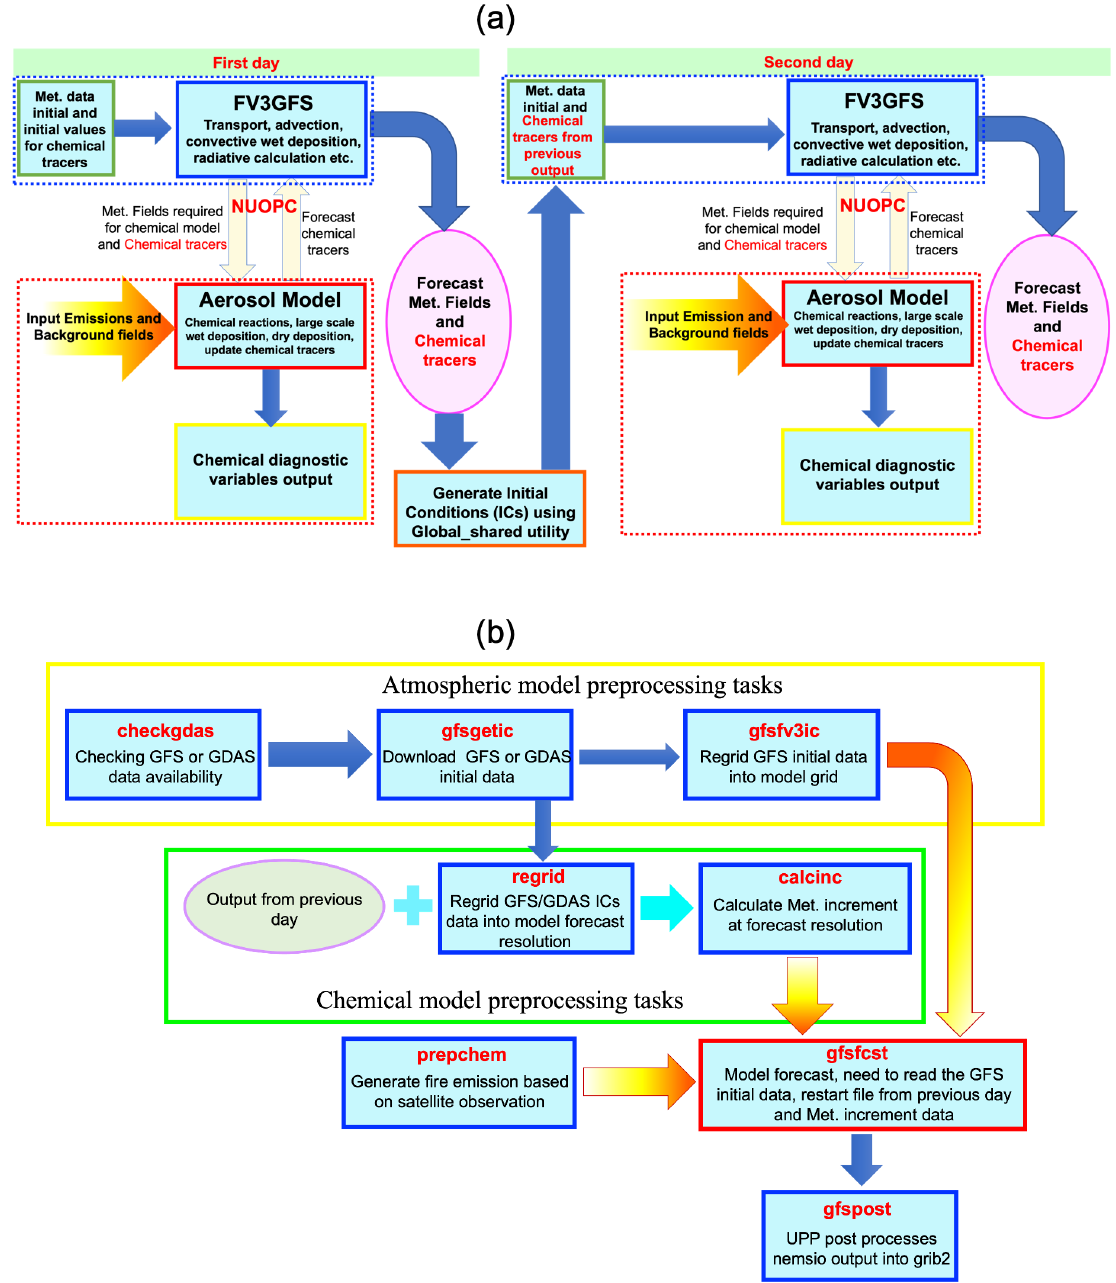
Figure 2. (a) Diagram of the GEFS-Aerosols coupled structure. (b) Flowchart of steps/tasks for GEFS-Aerosols in the global workflow forecast